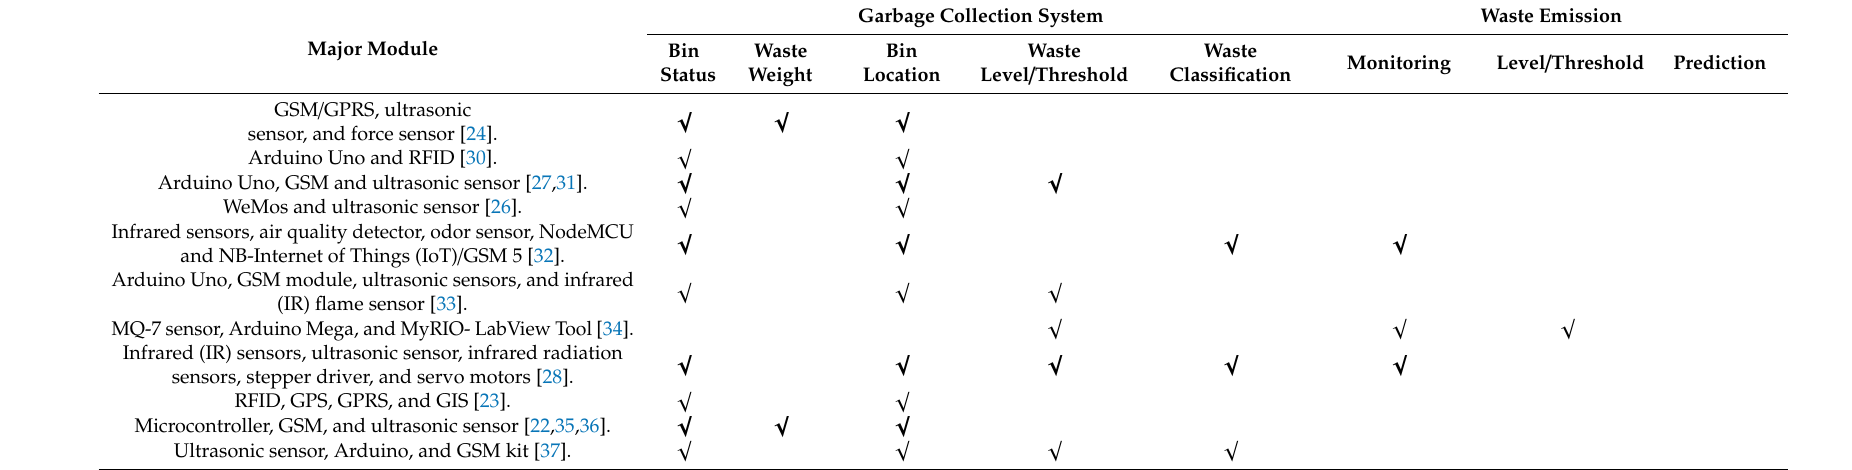
Table 1. A comprehensive literature review of the existing